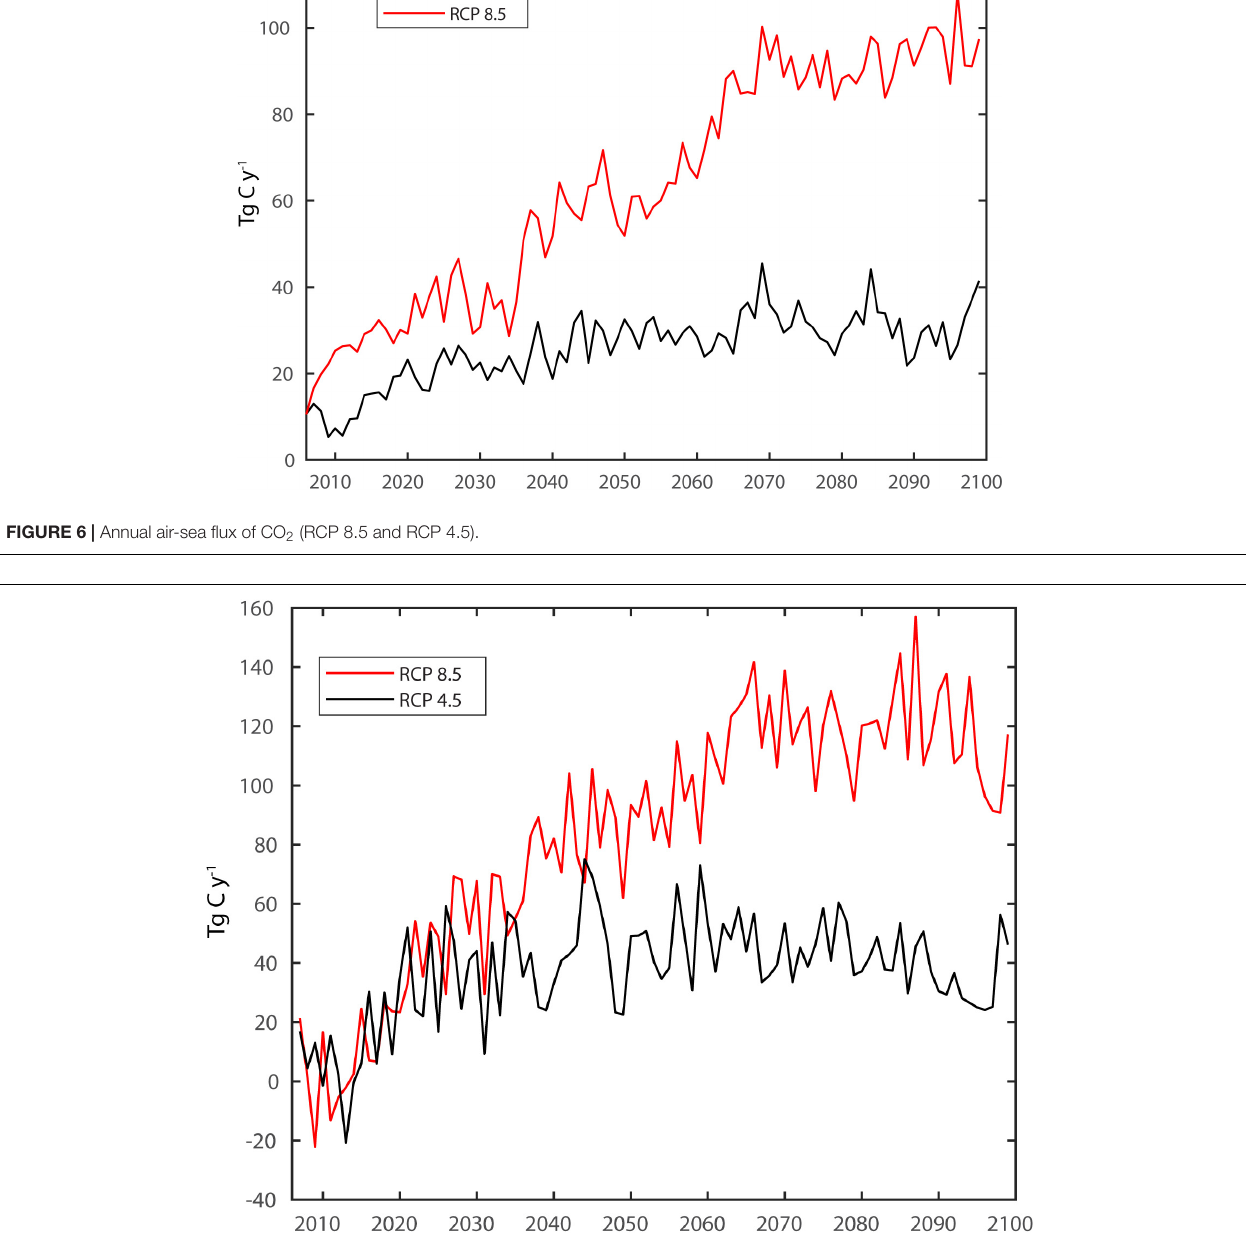
FIGURE 7 | Net annual accumulation rate of carbon in the Arctic Ocean for RCP 8.5 and RCP